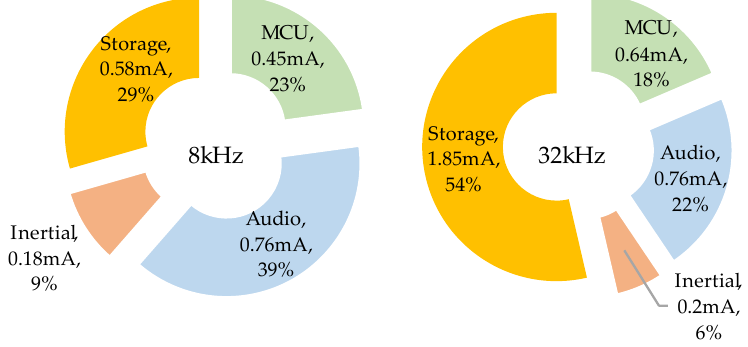
Figure 20. Consumption distribution among logger components.